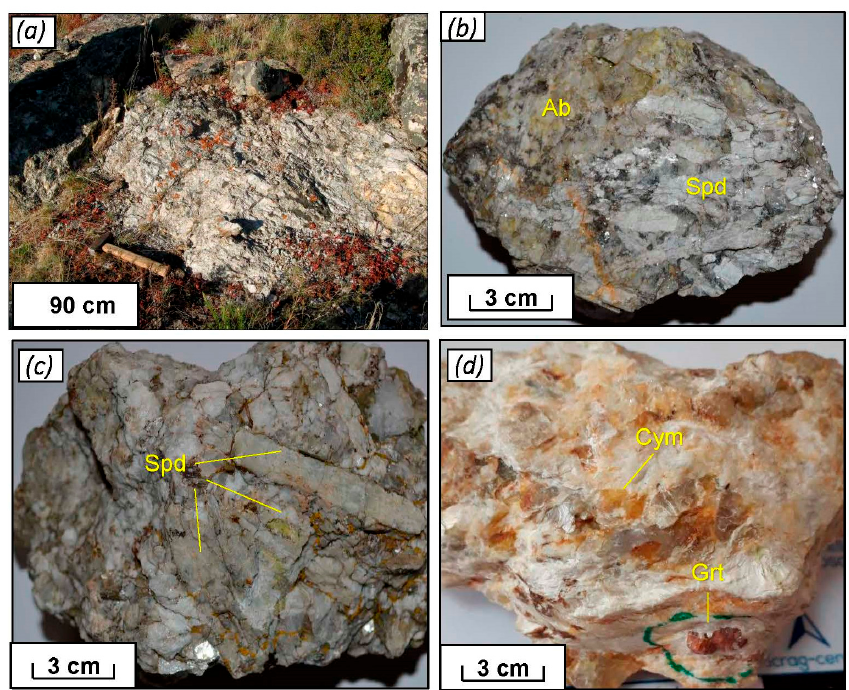
Figure 10. Albite–spodumene pegmatites from the Tochka area. ( a ) Nest of albite–spodumene peg- matite; ( b ) albite–spodumene pegmatite; ( c ) nest of flat spodumene crystals; ( d ) albitized pegmatite with cymatolite nests and garnet crystals.